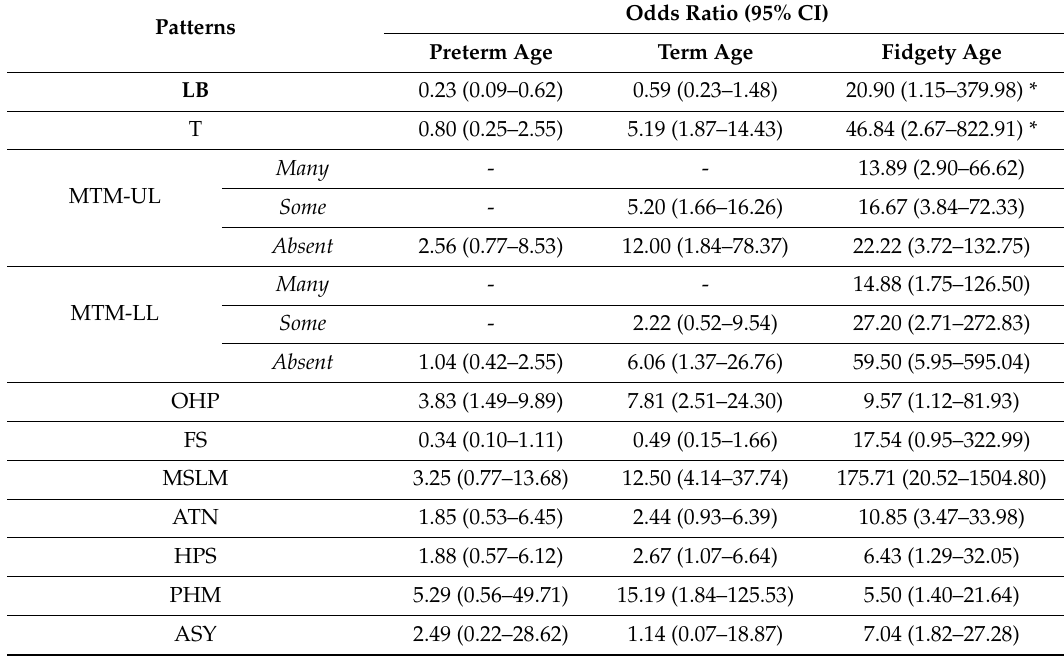
Table 6. Association between concomitant motor and postural patterns and cerebral palsy at the three key